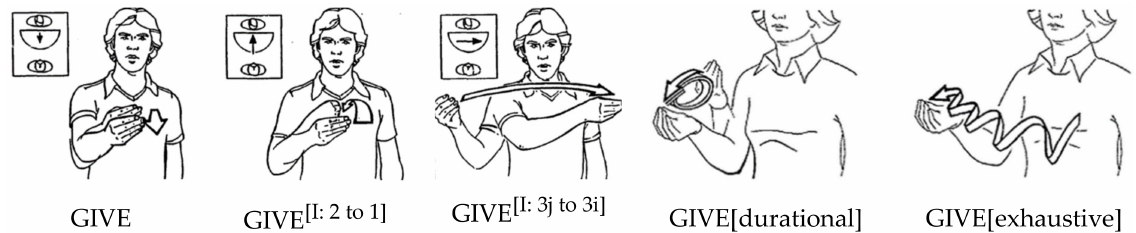
Figure 9. Notations for several inflections of GIVE [58,59].